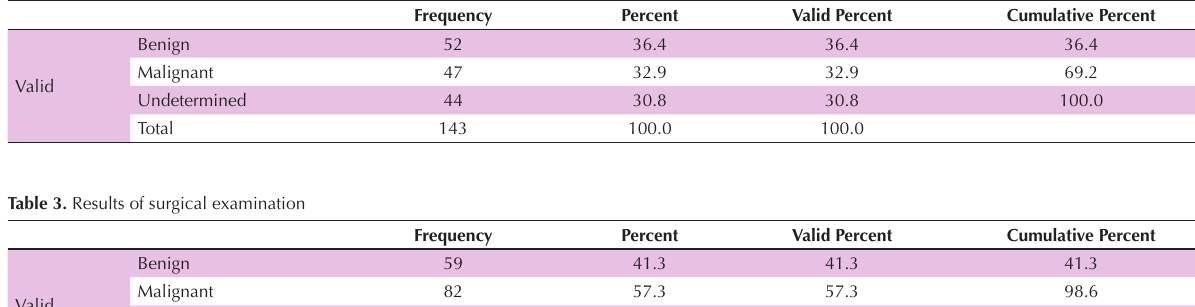
Table 2. Results of FNA study